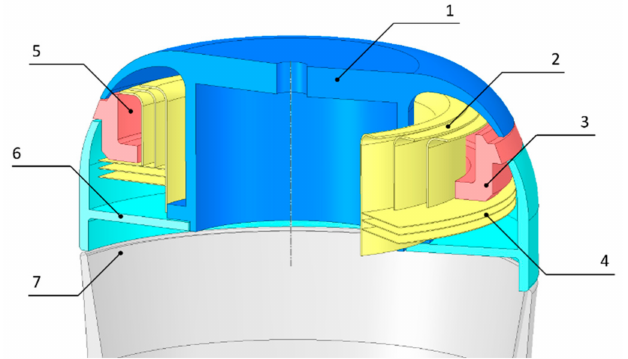
Figure 3. Magnetron Injection Gun (MIG) scheme: (1) nose-cone, (2) upper thermal shields, (3) emitter ring, (4) lower thermal shields, (5) filament cavity, (6) prolongator, and (7)